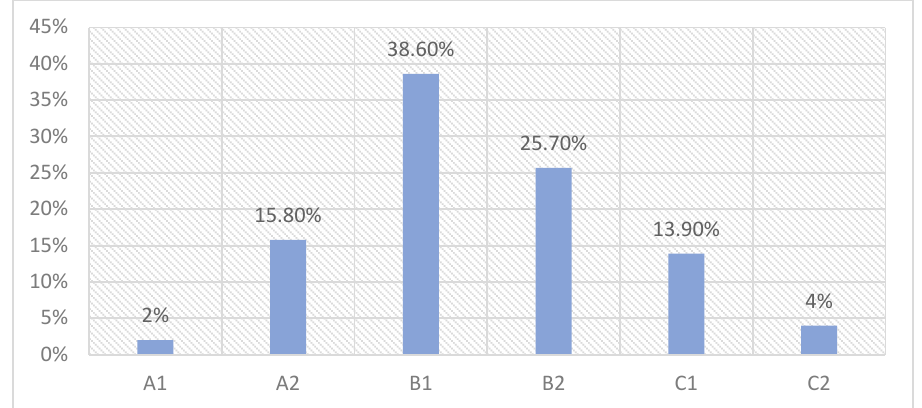
Figure 1. Overall ranking in Digital Competence in Teaching.